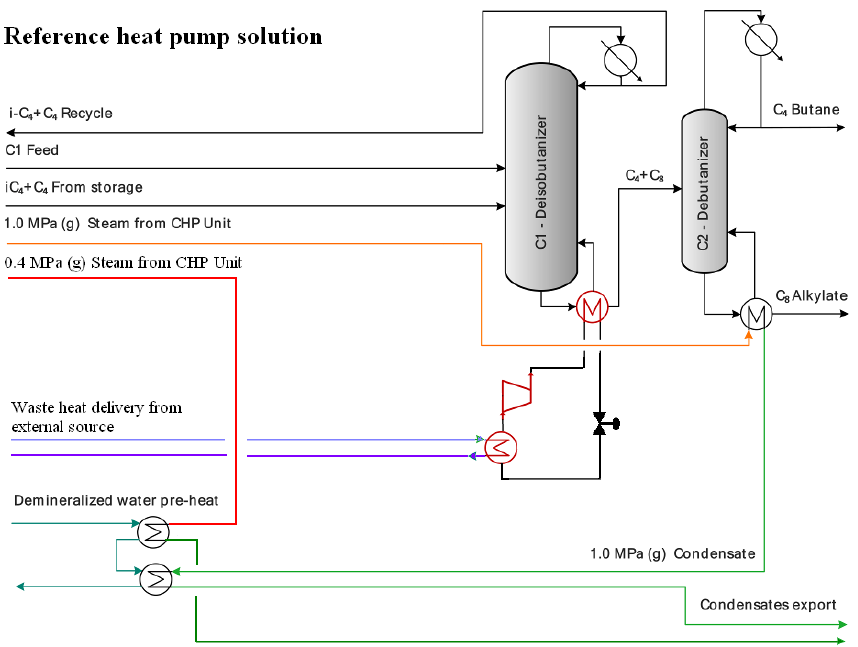
Figure 8. Traditional electro-driven heat pump-assisted distillation with external waste heat delivery: reference solution. New equipment, compared to process layout depicted in Figure 5, is highlighted in red.